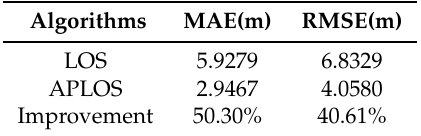
Table 10. Performance metric of a sinusoidal path following ( u = 1